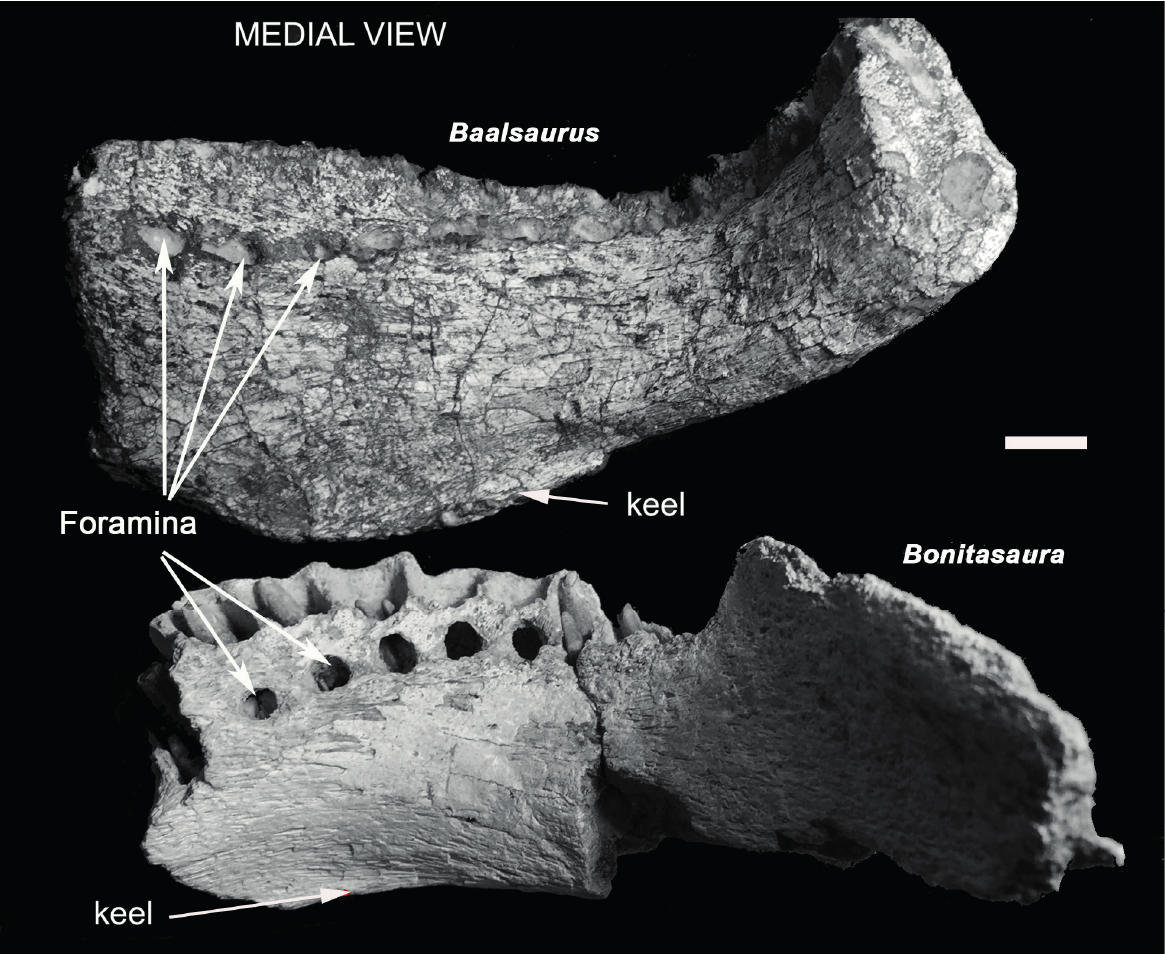
Figure 4 - Baalsaurus mansillai n.g.n.sp. medial view compared with Bonitasaura salgadoi. Scale bar: 1